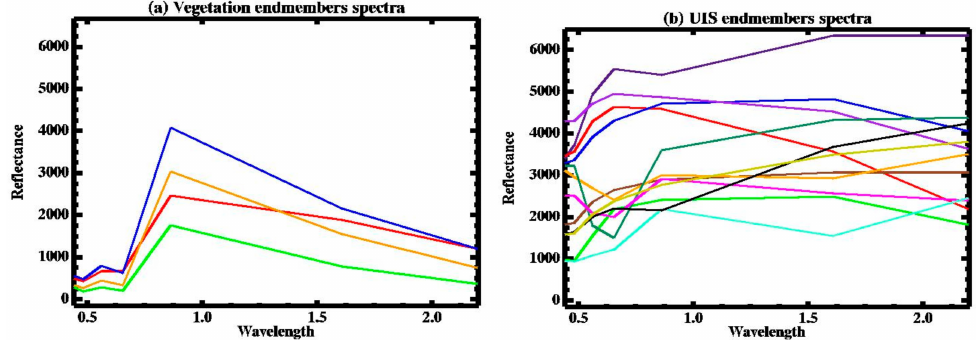
Figure 3. Spectra used to classify land cover in this study; ( a ) Vegetation endmembers spectra; ( b ) UIS endmembers